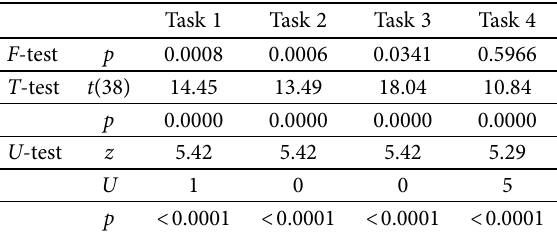
Table 10. Statistical test of the PLES and the ASA performance for group transportation in all Tasks